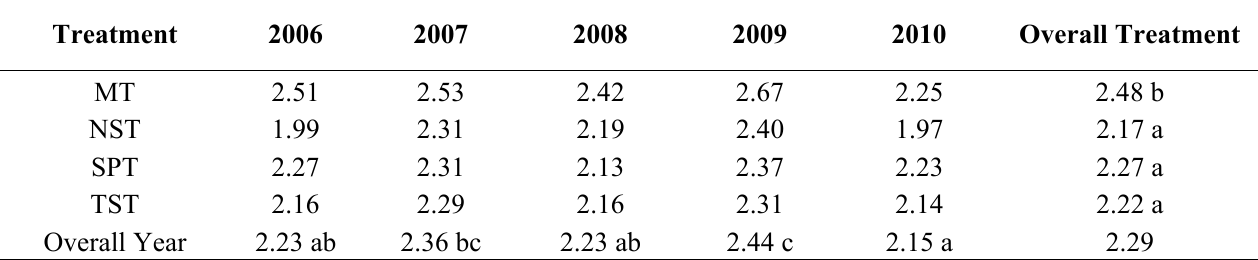
Table 2. Estimated average GHG emissions (kg CO lambs removed from the treatment group at slaughter weight of 38 kg 1